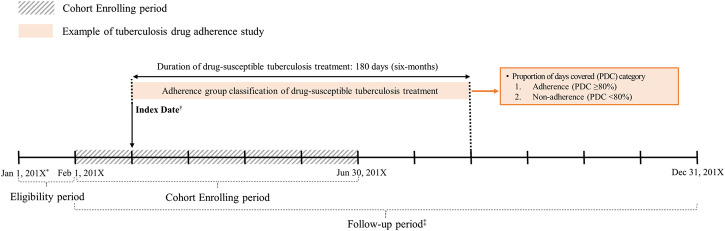
Study design of drug-susceptible tuberculosis adherence study. *201X: 2017 or 2018. †The first date of prescription with a quadruple or triple regimen. ‡Prescribed at least one of first-line tuberculosis drugs; first-line drugs for drug-susceptible tuberculosis: isoniazid, rifampicin (rifampin), rifabutin, ethambutol, pyrazinamide.